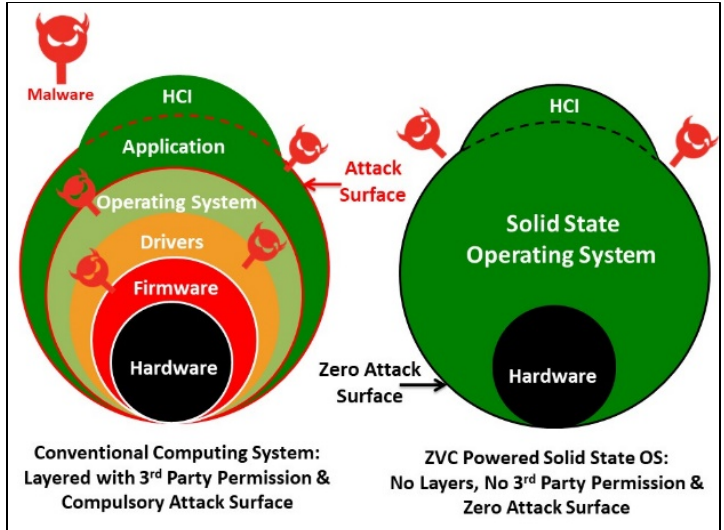
Figure 15. Diagrammatic illustration of the conventional multi-layered computer architecture in comparison to the projected compact zero attack surface design of ZVC.